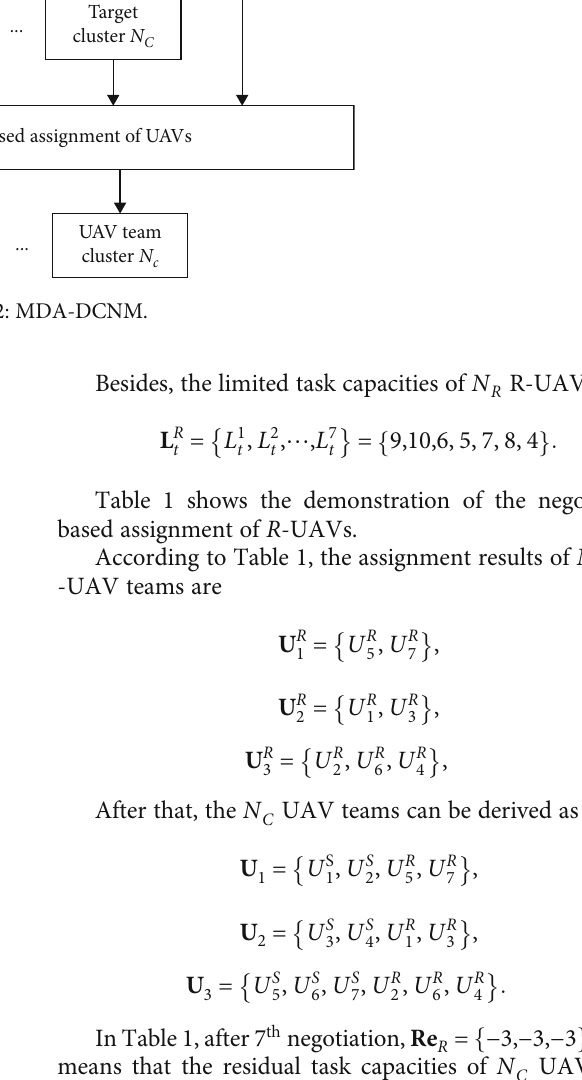
Algorithm 1: Density clustering of